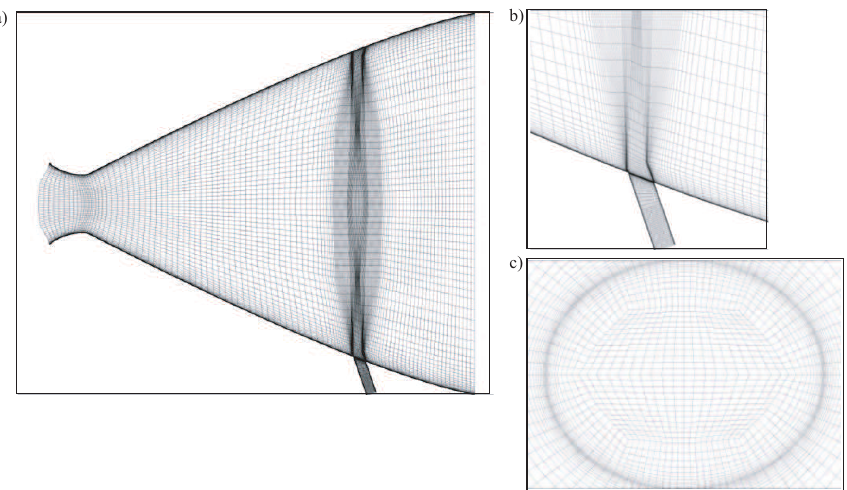
Figure 6. Computational mesh ( a ), mesh near injection port ( b ) and mesh in cross section of the injection port ( c ) with l j = 0.7, α j = 130 ◦ , d 2 / d 1 = 1, A ∗ / A a = 1.